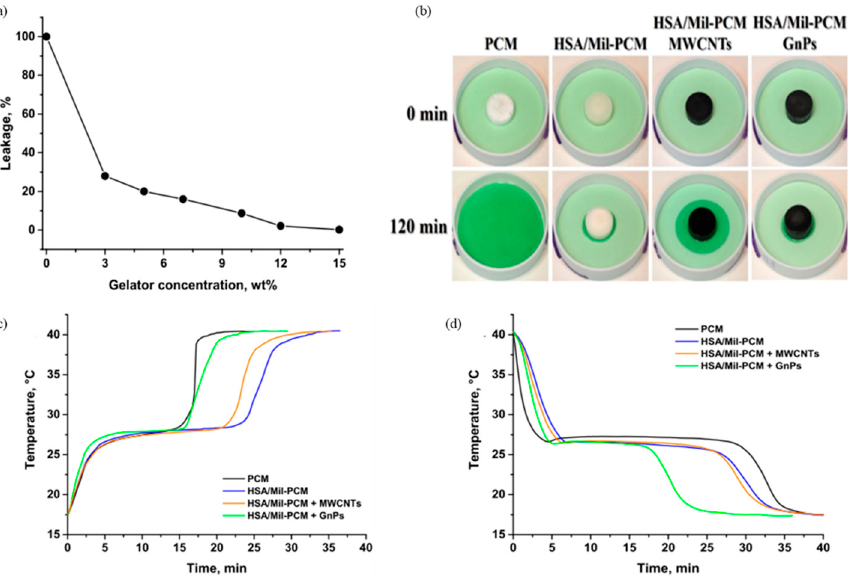
Figure 15. ( a ) GTA versus leakage rate; ( b ) leakage of the samples used; ( c ) heating curve; and ( d ) cooling curve [101]. Table 3. Notable observations from the existing PCM + NT+ GTA studies with NPs.